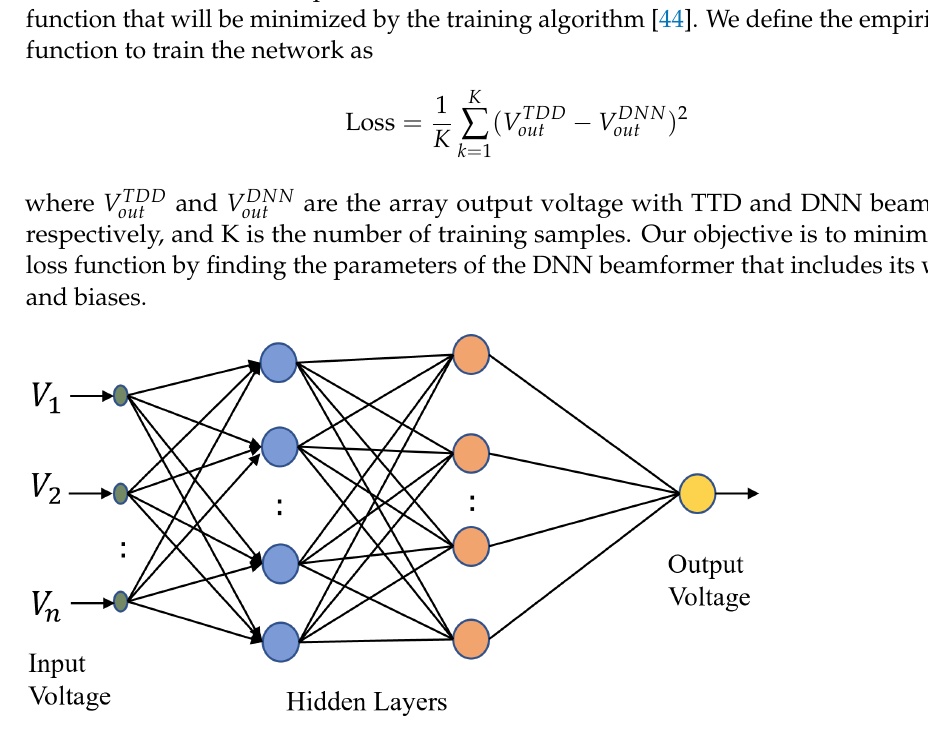
Figure 2. Schematic of the DNN Beamforming with input being fed by the voltages from individual array antenna